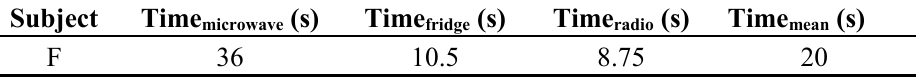
Table 6. Selection time using